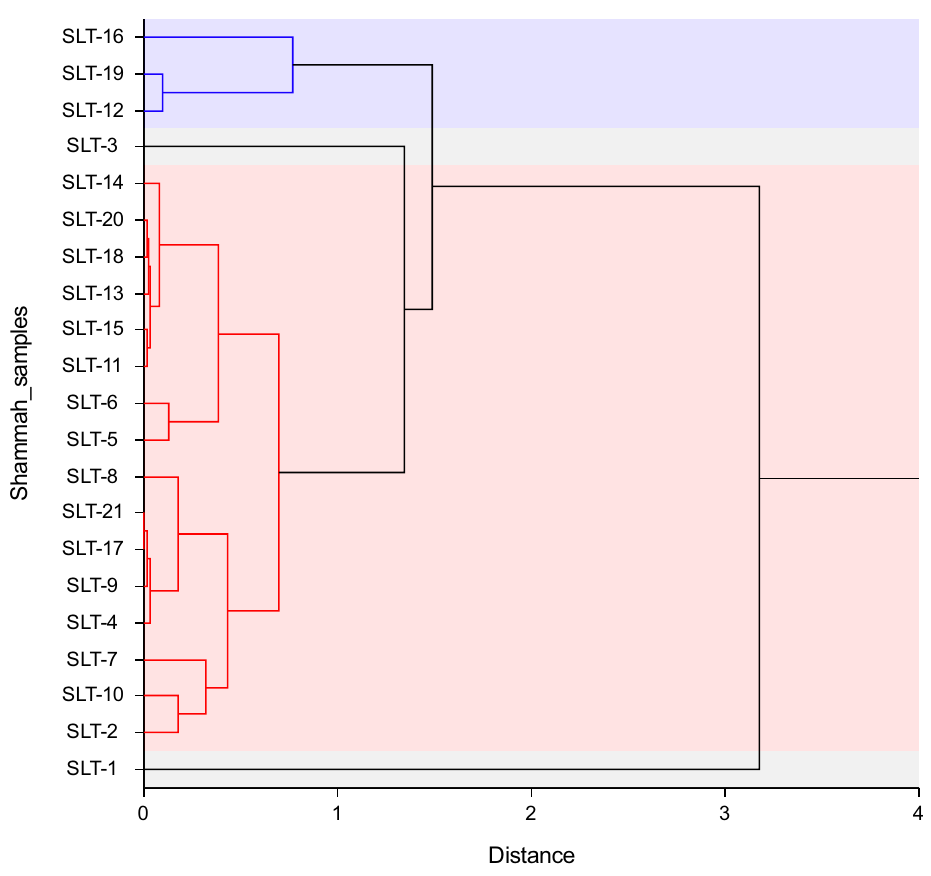
Figure 4: Dendrogram tree obtained for the 21 Shammah samples showing clusters of samples and distance indicating similarities between